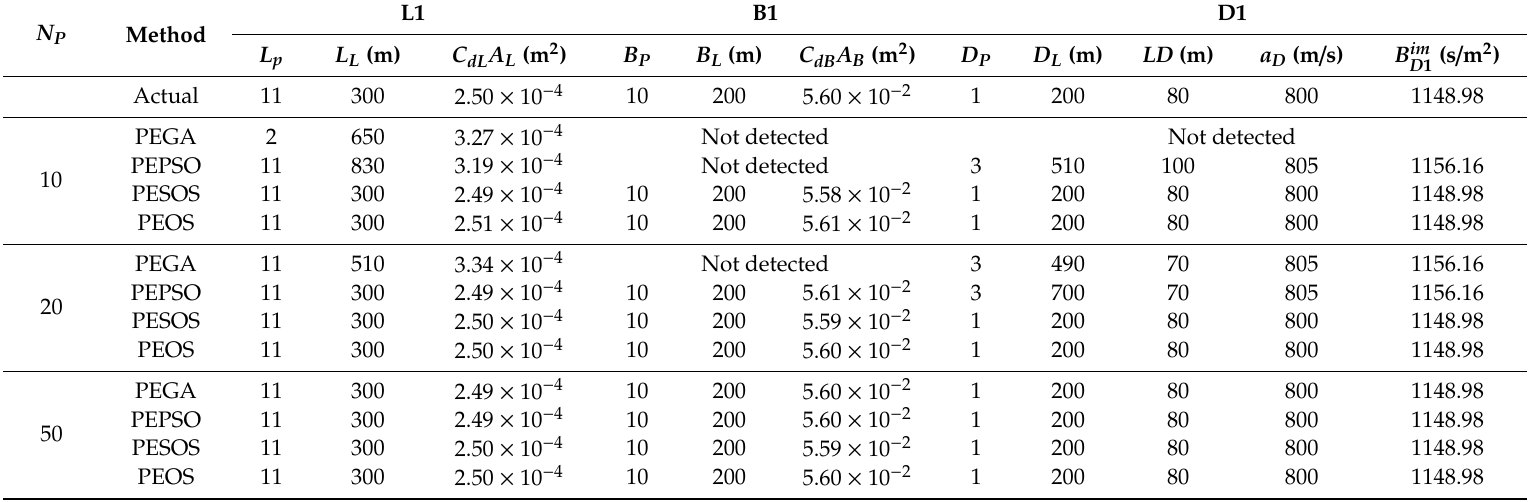
Table 5. Determined fault information of pipe network